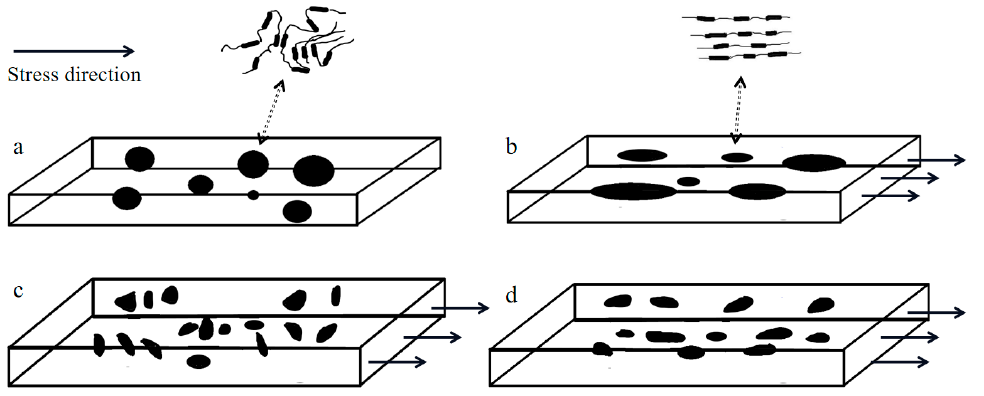
Figure 5. Schematic diagram of microphase changes during loading. (The cuboid represents the soft segment, and the black part indicates the hard segment.).( a ) TPU original state.( b ) TPU orientation stage.( c ) TPU hard segment dissociation stage.( d ) TPU secondary orientation stage.